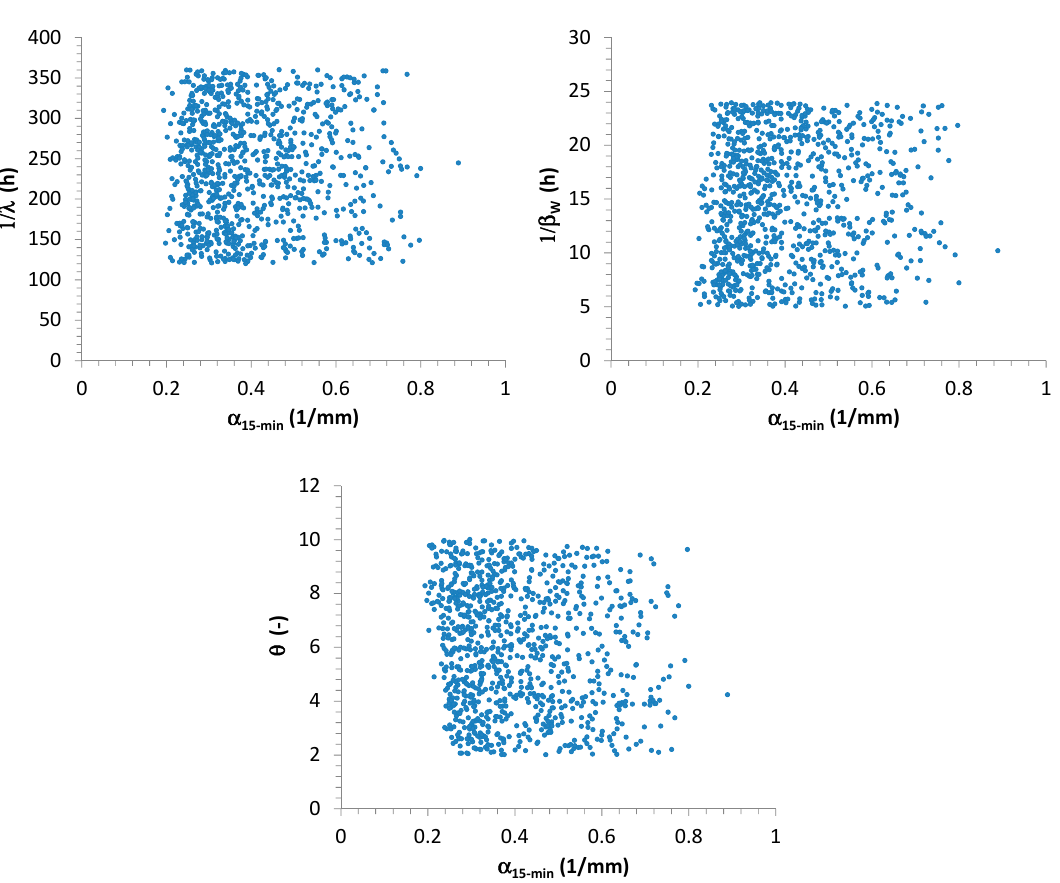
α Figure 4. Scatter plots among α , which were estimated from 15-min synthetic AMR series, and λ , β W , Figure 4. Scatter plots among , which were estimated from 15-min synthetic AMR series, and and θ θ β , W , and .